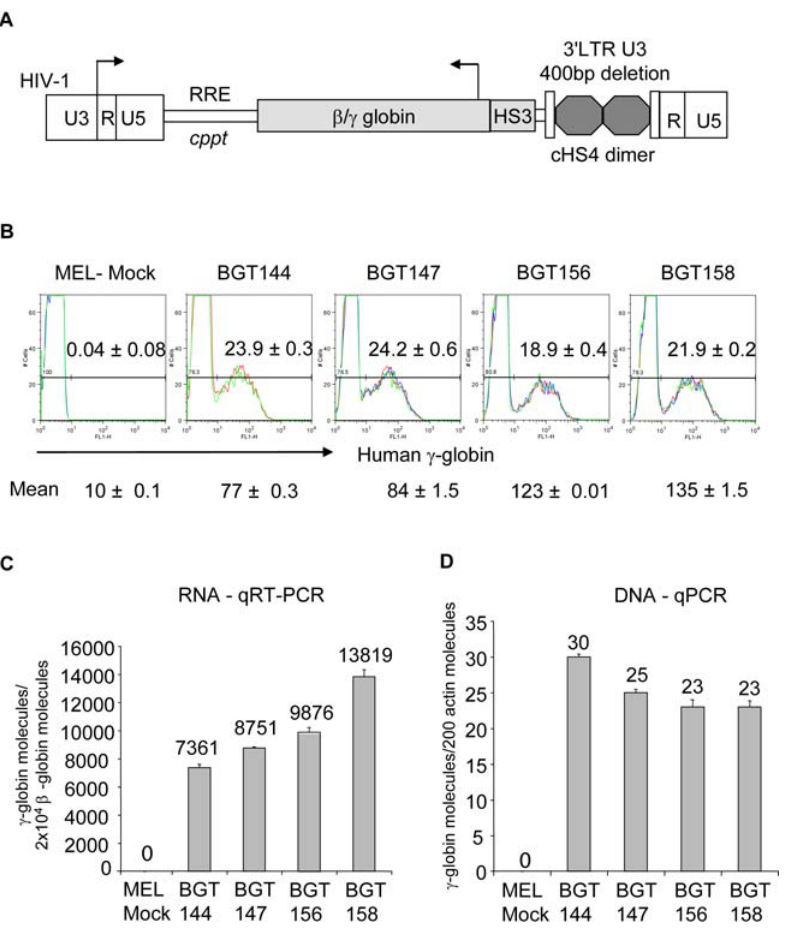
Figure 9. Insulated SIN lentivirus vectors containing 5 9 HS3 b / c -globin transgenes express in MEL cells. (A) Map of the PL.SIN.cHS4 lentivirus showing the HIV 5 9 LTR, cppt, RRE, 5 9 HS3 b / c -globin transgene and the 400 bp SIN deletion of the 3 9 LTR bearing the dimer core cHS4 Insulator. (B) Lentivirus vectors containing the intronic Ig m 3 9 MAR express the highest mean A c -globin protein levels assessed by flow cytometry of MEL cells infected at low MOI. Data with approximately 20% A c -globin protein expressing cells is shown by flow cytometry performed in triplicate 6 SE after 6 days induction with HMBA. (C) Lentivirus vectors containing the intronic Ig m 3 9 MAR express the highest A c -globin RNA levels. qRT-PCR results in triplicate 6 SE were performed on the 20% protein positive infected MEL cells after 3 days induction with HMBA. RNA expression is shown as A c -globin molecules per 2 6 10 4 mouse b major-globin molecules after correction for the lentivirus copy number. (D) The lentivirus copy number is approximately equal in each infection. qPCR analysis of lentivirus copy number 6 SE in the MEL cell genome. The number of transgene molecules was determined by amplification with 3 9 b -globin enhancer primers and plotted versus 200 mouse b -actin molecules. These data correspond to the % of infected MEL